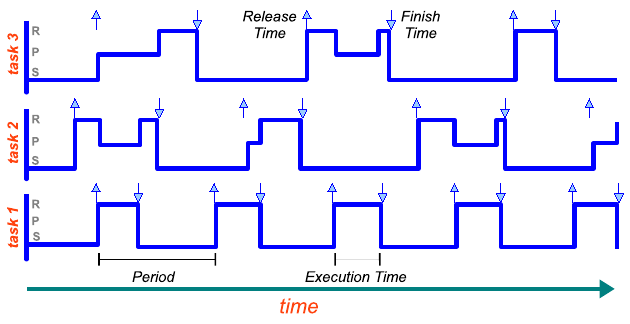
Schedule plot: three periodic tasks are running on the same CPU, tasks 1 and 3 have the highest and lowest priority respectively. Up arrows in a task plot indicate the released times of that task, down arrows indicate the task finish times. The initials R, P, and S indicate the possible states of the tasks. Note that the task 1 is never